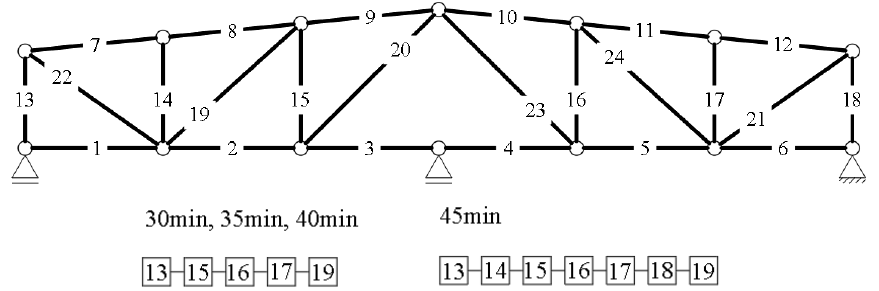
Figure 11. Statically indeterminate structure with six degrees of freedom with intermediate support (after 2nd reduction) and corresponding cut-sets. Table 4. The number and time of cut-sets searching for Trusses 1, 2, 3.